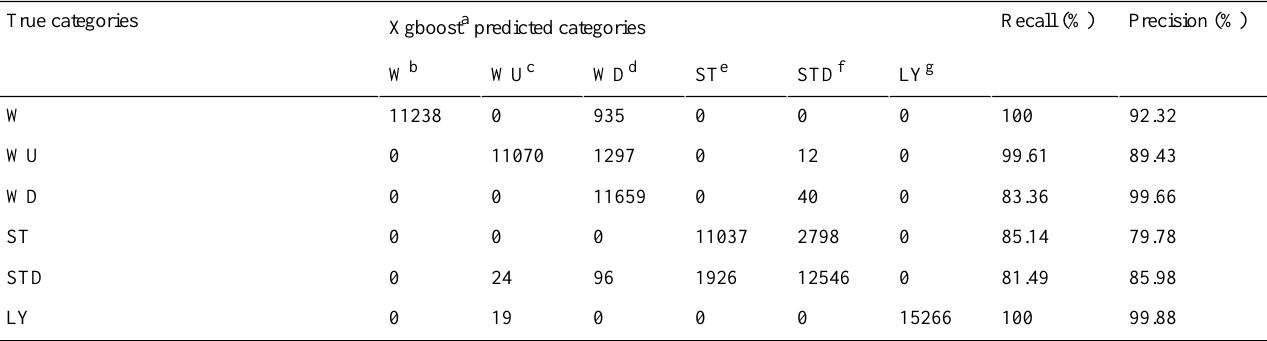
Table 1. Confusion matrix of instantaneous predictions using greedy Gaussian segmentation from the 6 test experiments in the Human Activity Recognition using Smartphones dataset.